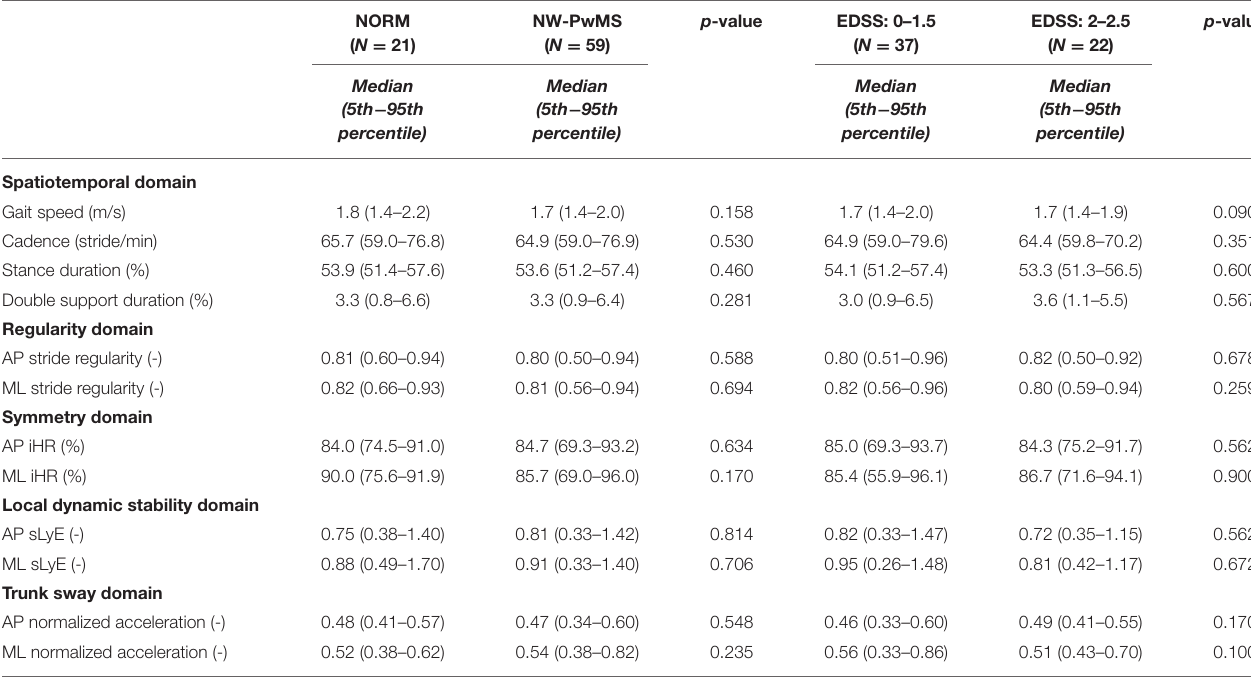
TABLE 3 | Instrumented metrics describing fast straight-line walking in normal-walking people with MS (NW-PwMS) and healthy subjects previously tested